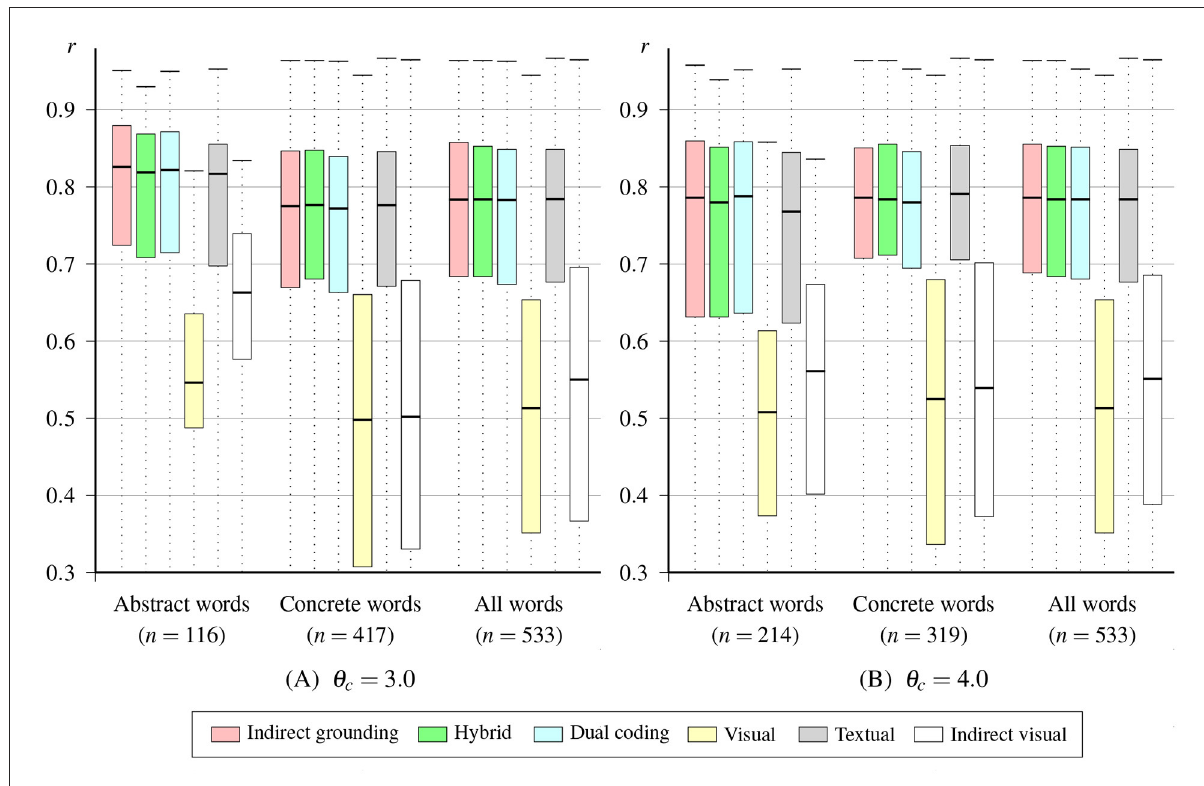
FIGURE3 Boxplots of word correlations for the indirect grounding model and other models.